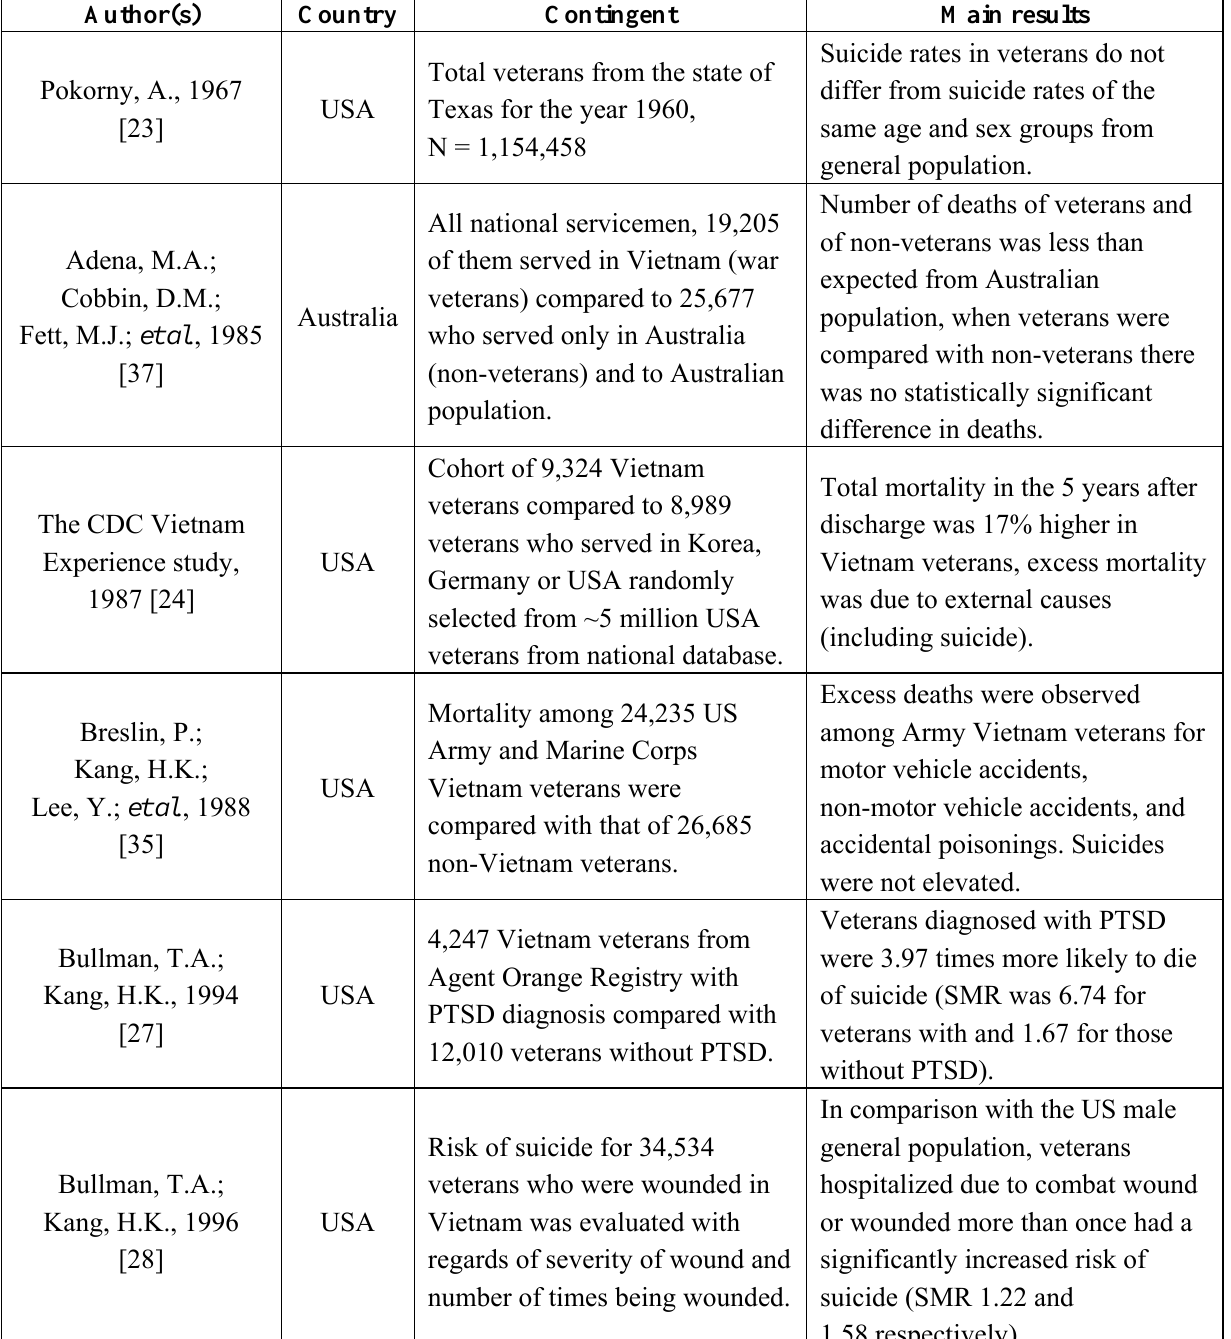
Table 1. Studies on suicidality among war